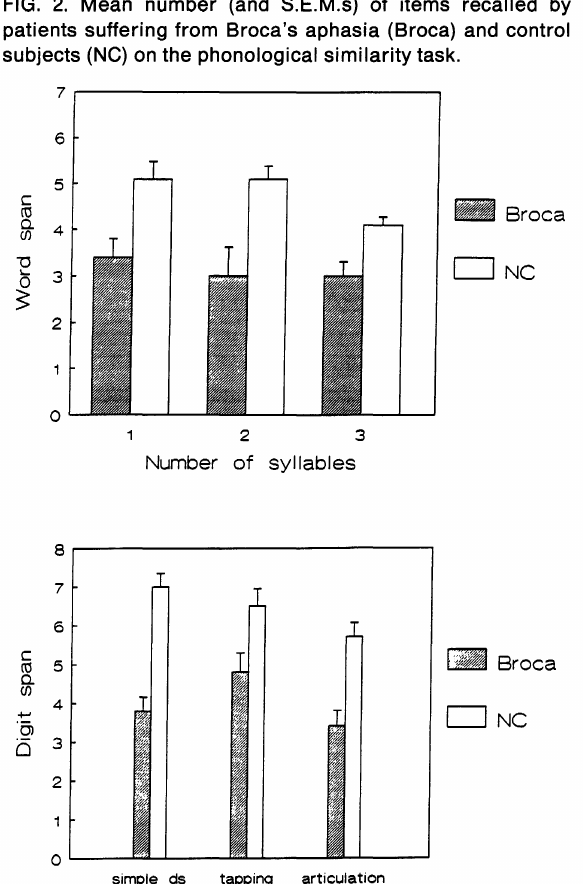
FIG. 2. Mean number (and S.E.M.s) of items recalled by patients suffering from Broca's aphasia (Broca) and control subjects (NC) on the phonological similarity task.